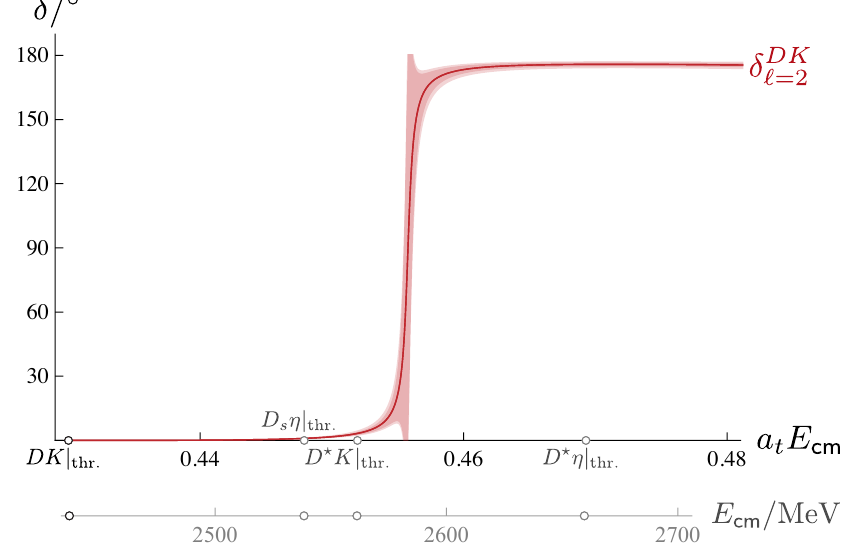
Figure 13 . D -wave scattering phase shift for I = 0 DK on the m π = 391 MeV ensembles using the parametrisation in eq. (5.11). The darker inner band indicates the statistical uncertainties, while the lighter outer band reflects the uncertainty from varying the D and K meson masses and the anisotropy as described in the